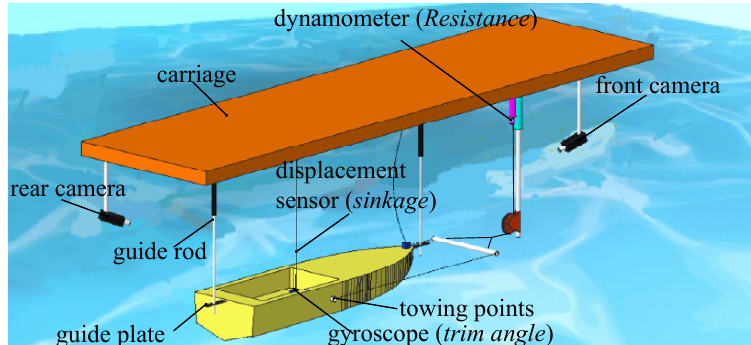
Figure 3. Schematic diagram of the experimental setup.